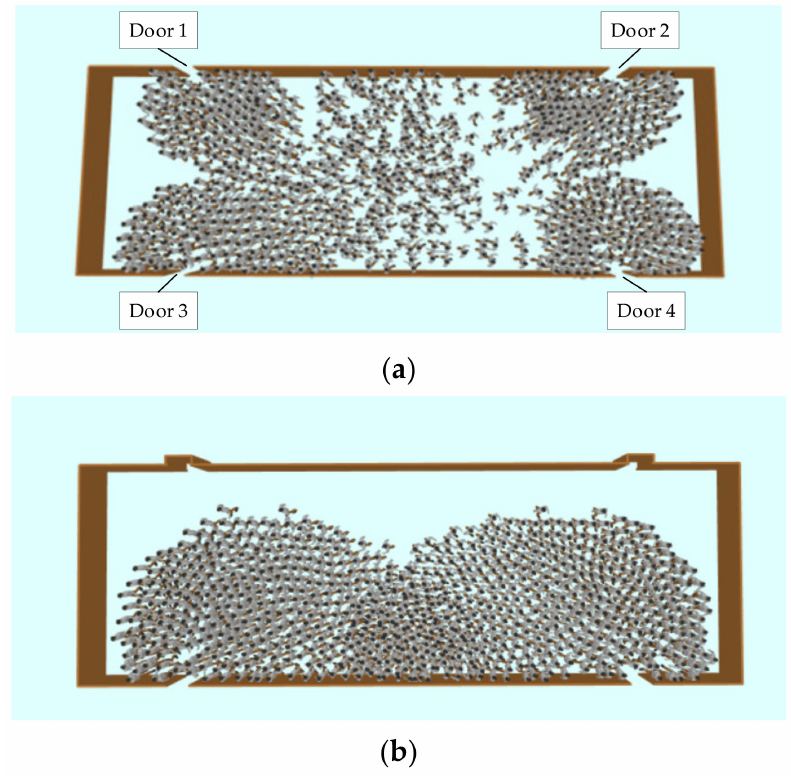
Figure A8. The scenario of test 8. ( a ) Four exits; ( b ) Two exits. Text 9: Exit route allocation.